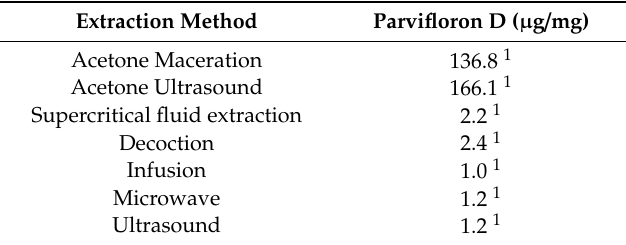
Table 1. Amount of parvifloron D in 1 mg of P. ecklonii